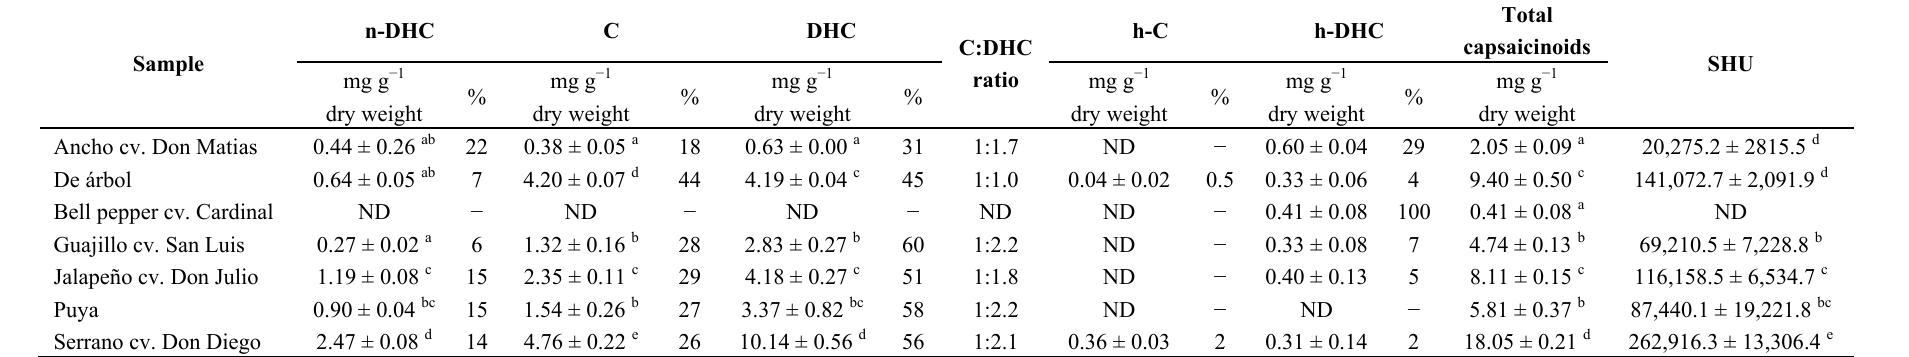
Puya Serrano cv. Don Diego Table 2. Content of capsaicinoids in chili samples grown in an environment with thermal stress. Nordihydrocapsaicin (n-DHC), capsaicin (C), dihydrocapsaicin (DHC), homocapsaicin (h-C) and homodihydrocapsaicin (h-DHC); SHU = Scoville heat units. Content of nordihydrocapsaicin and homodihydrocapsacin were calculated as equivalents of dihydrocapsaicin; the content of homocapsaicin was calculated as equivalents of capsaicin. Means in the same column followed by di ff erent letters (a–e) were signi fi cantly di ff erent by Tukey’s test at p ≤ 0.05. ND = not